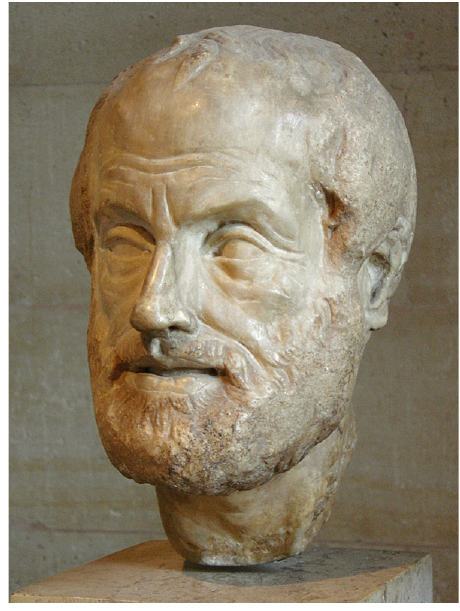
Figure 1: Replica of Lysippos’